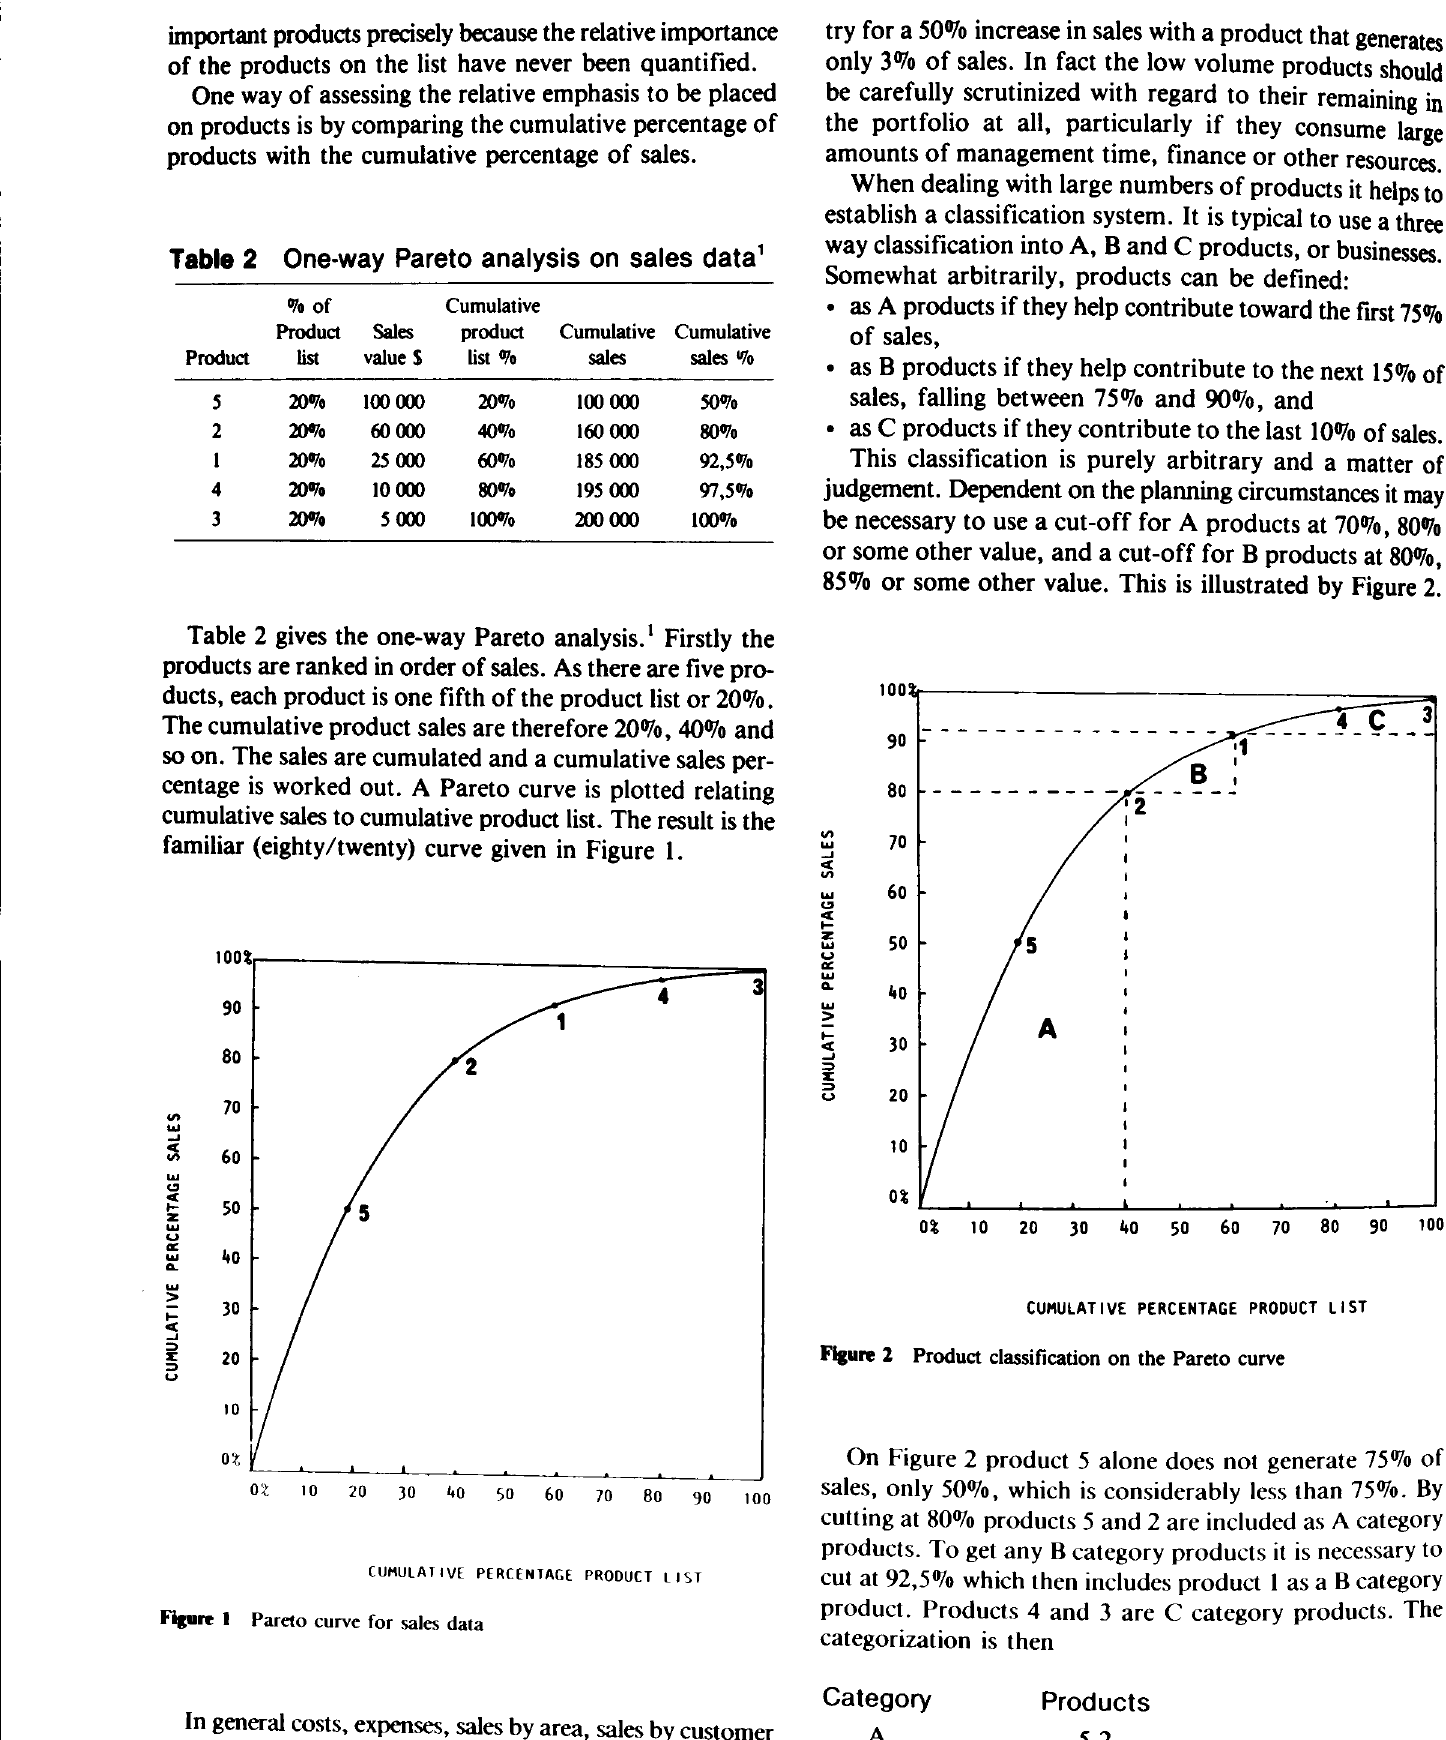
Figure 2 Product classification on the Pareto curve